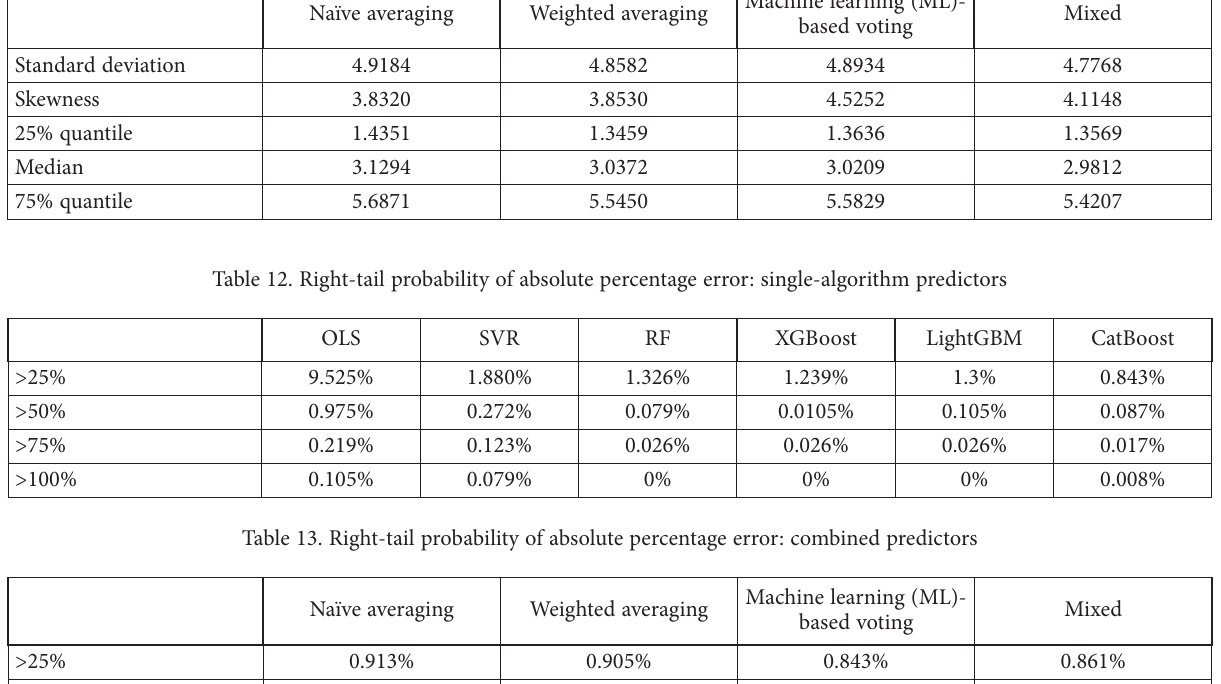
Table 11. Statistics for absolute percentage error: combined predictors Naïve averaging Weighted averaging